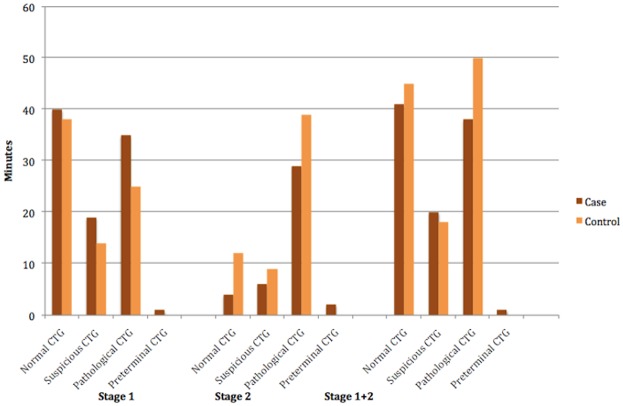
Durations of cardiotocographic (CTG) changes.